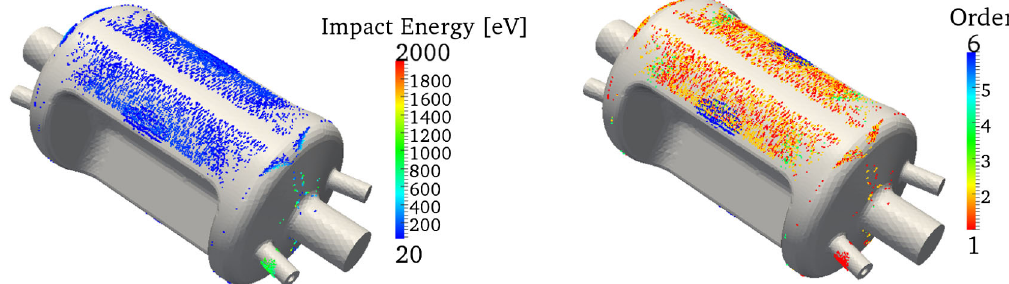
FIG. 10. Position of the resonant particles on the rf-dipole cavity with corresponding impact energy (left) and multipacting order